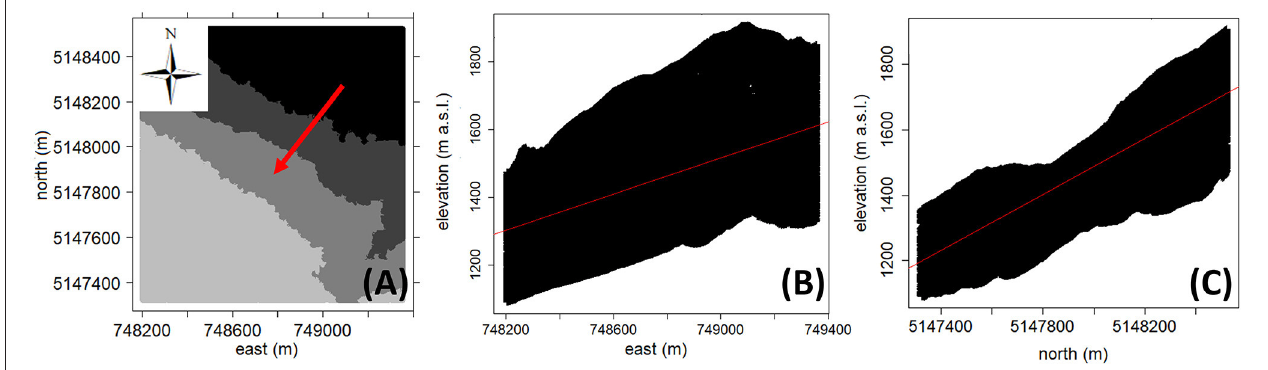
FIGURE 4 | Quantiles map of the variable elevation (the red arrow indicates the trend direction, which corresponds to the channel gradient) (A) , scatterplot elevation values versus east coordinate (rho Pearson 0.48; rho Spearman 0.47) (B) , and scatterplot elevation values versus north coordinate (rho Pearson = = Spearman 0.84) (C) =